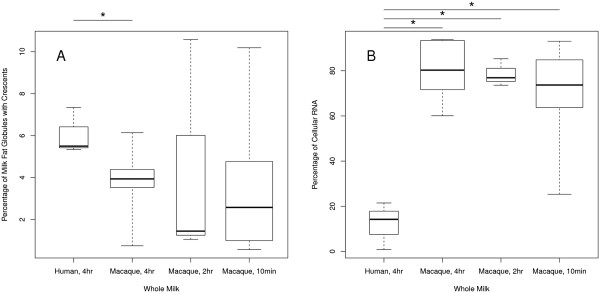
Percentage of cytoplasmic crescents and cells in milk. Milk samples were collected after a 4-hr accumulation period in human subjects and a 4-hr, 2-hr, or 10-min accumulation in macaques. The boxplots show the (A) percentage of milk fat globules with cytoplasmic crescents and (B) the percentage of RNA attributable to nucleated cells in these milk samples. (A-B) The upper and lower bounds of each box denote the first and third quartiles of the data, the dark horizontal line within each box denotes the median value, and the whiskers extend to the minimum and maximum values. The width of each box is proportional to the square root of the samples size. Asterisks denote statistical significance (p < = 0.05).